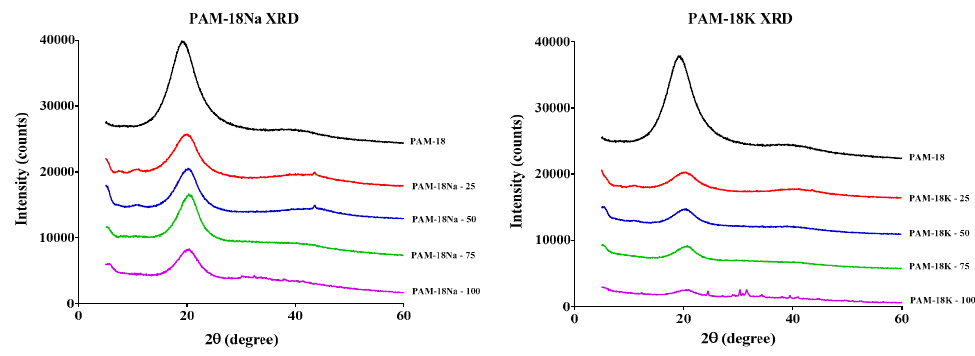
Figure 3. X-ray powder diffractograms of polymers derived from PAM-18.